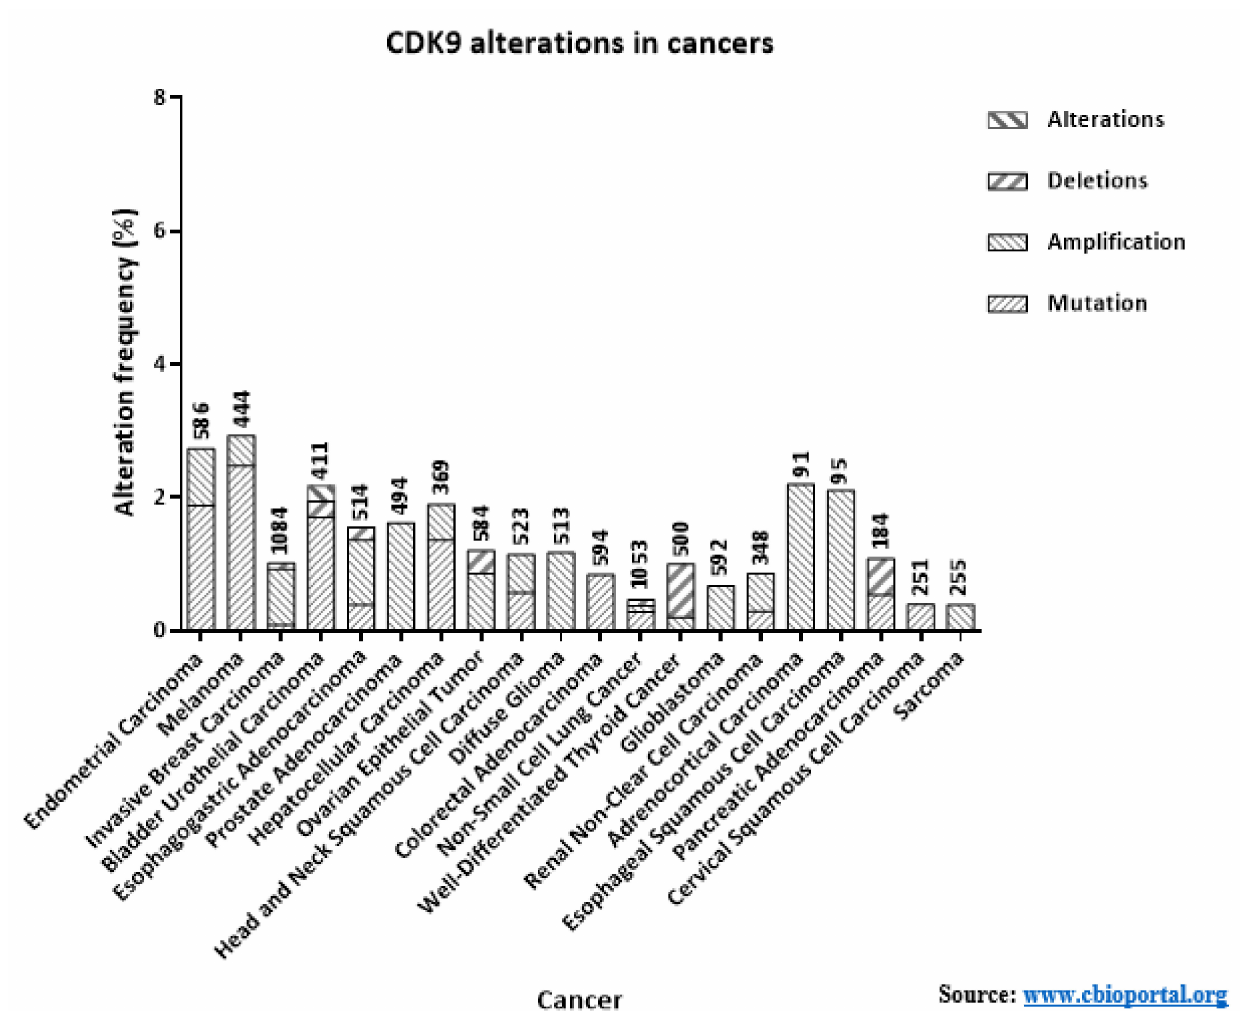
Figure 5. The alterations of the CDK9 gene in various cancer entities. The alteration frequency of the CDK9 gene in various cancers have been represented graphically. The alterations involve deletions, mutations, copy number amplifications and other alterations. The numbers on top of each cancer entity are the respective patient numbers represented. The data were obtained from www.cbioportal.org (accessed on 16 February